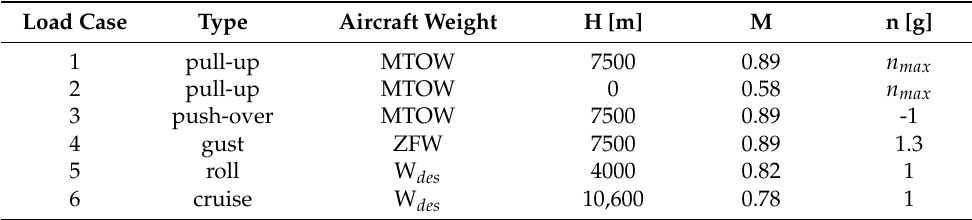
Table 5. SE 2 A midrange load cases.